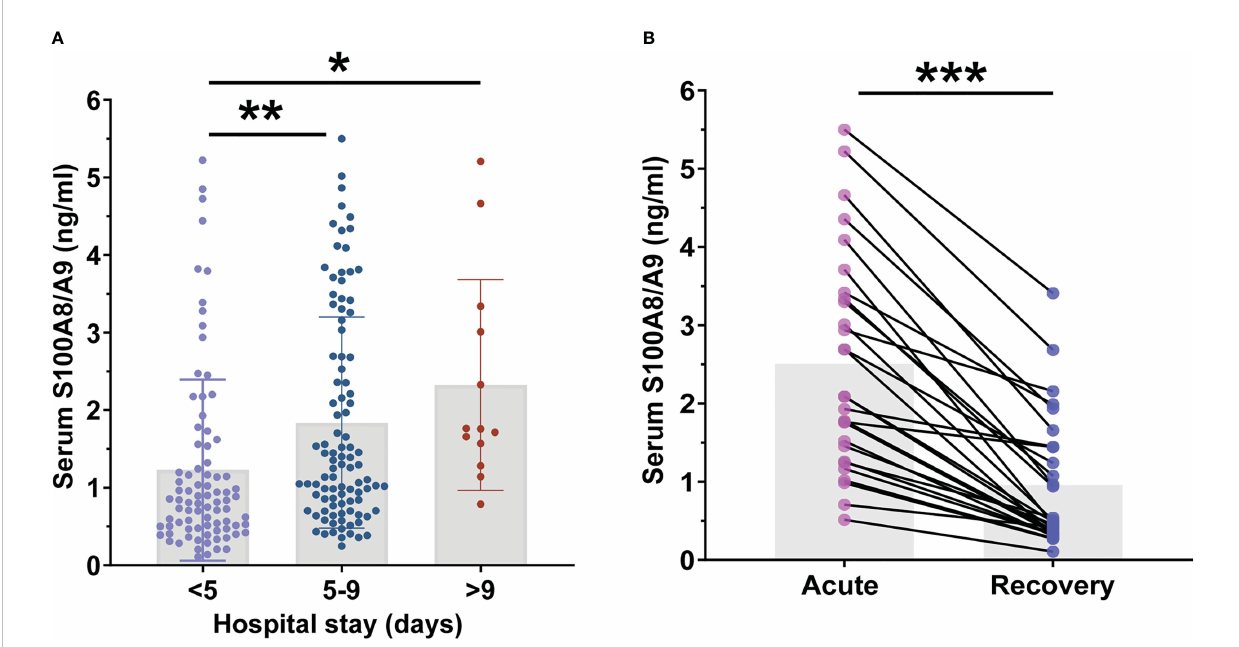
FIGURE 4 The levels of serum S100A8/A9 in community-acquired pneumonia (CAP) children with different prognosis. (A) The levels of serum S100A8/A9 in CAP children with different hospital stays. (B) Serum S100A8/A9 in children with CAP at different phase. All data were expressed as mean ± SEM. * P < 0.05, ** P < 0.01, *** P <